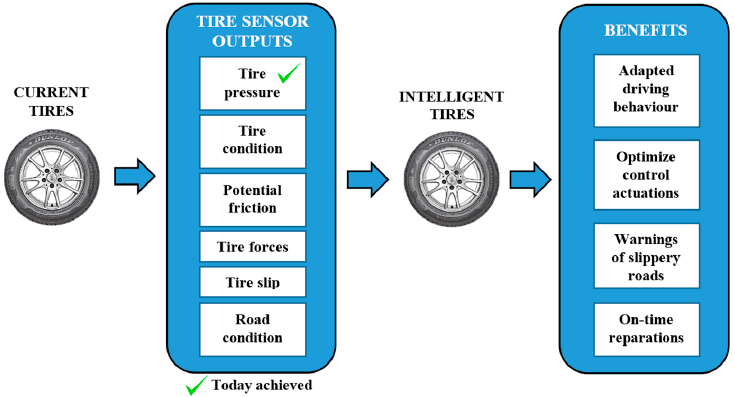
Figure 1. State-of-the-art in the use of tire-related information for vehicle control and driver information. Due to tire-road contact features, which are nonlinear, it is difficult to apply the exact brake pedal force to stop the vehicle for the minimum distance without locking the wheels and, as a